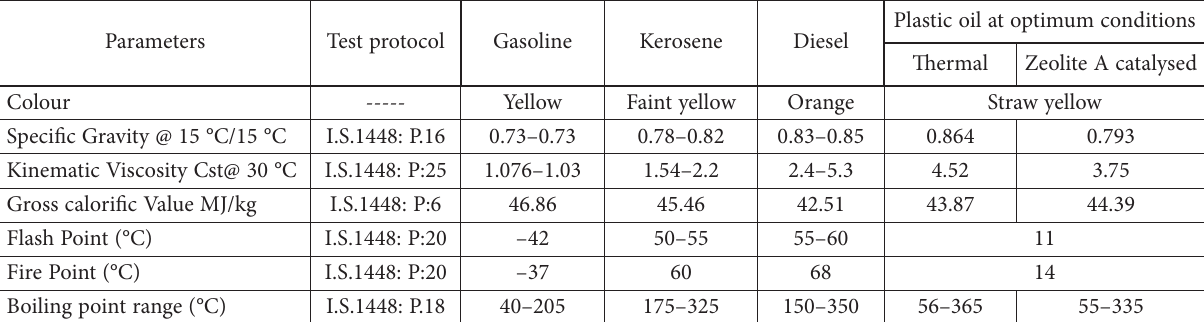
Figure 18. GC-MS plot of the pyrolysis oil Table 6. Fuel properties of oil